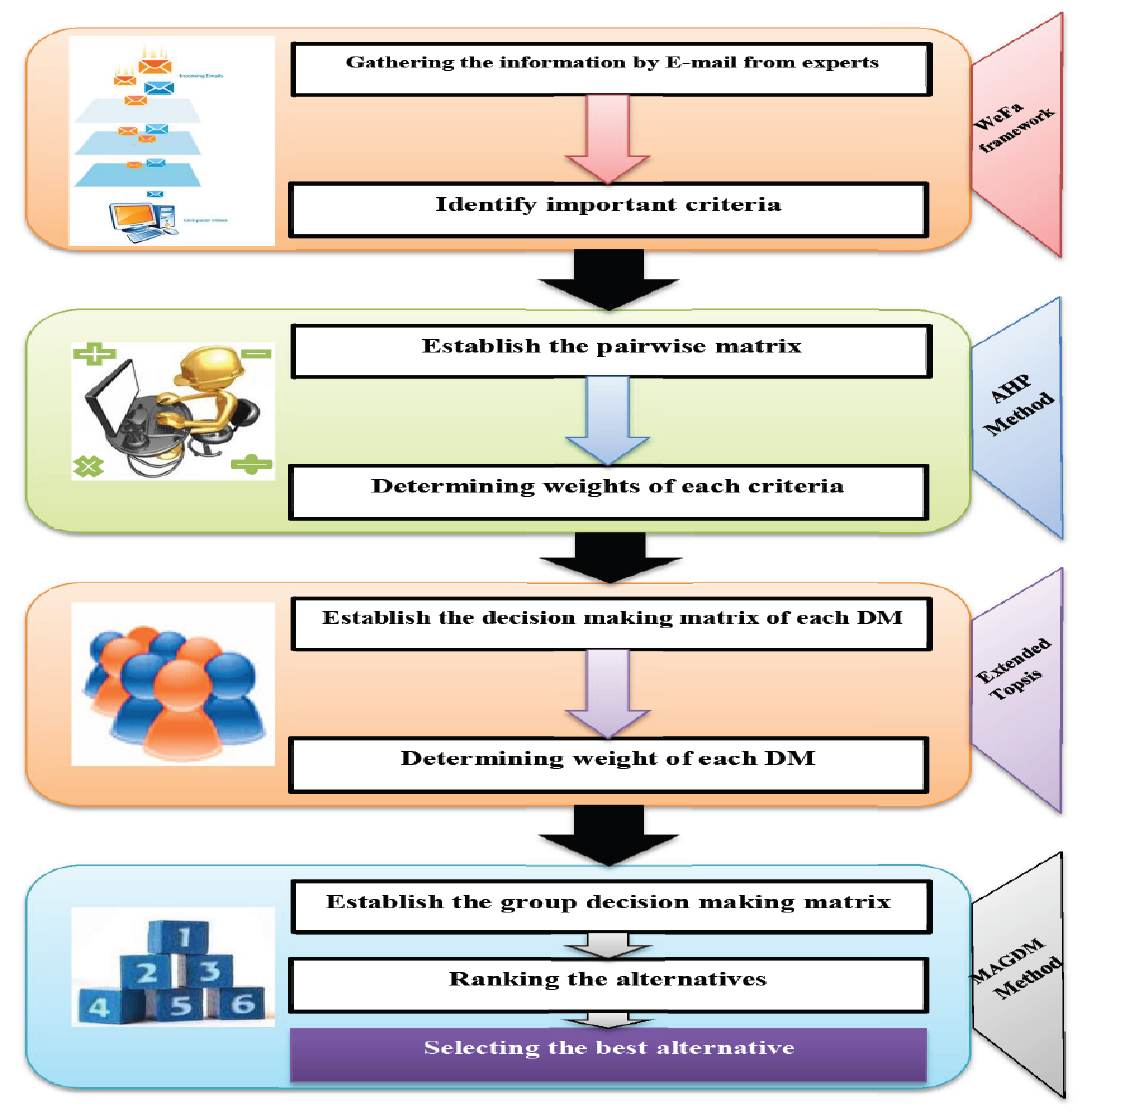
Fig.1 . the proposed combined